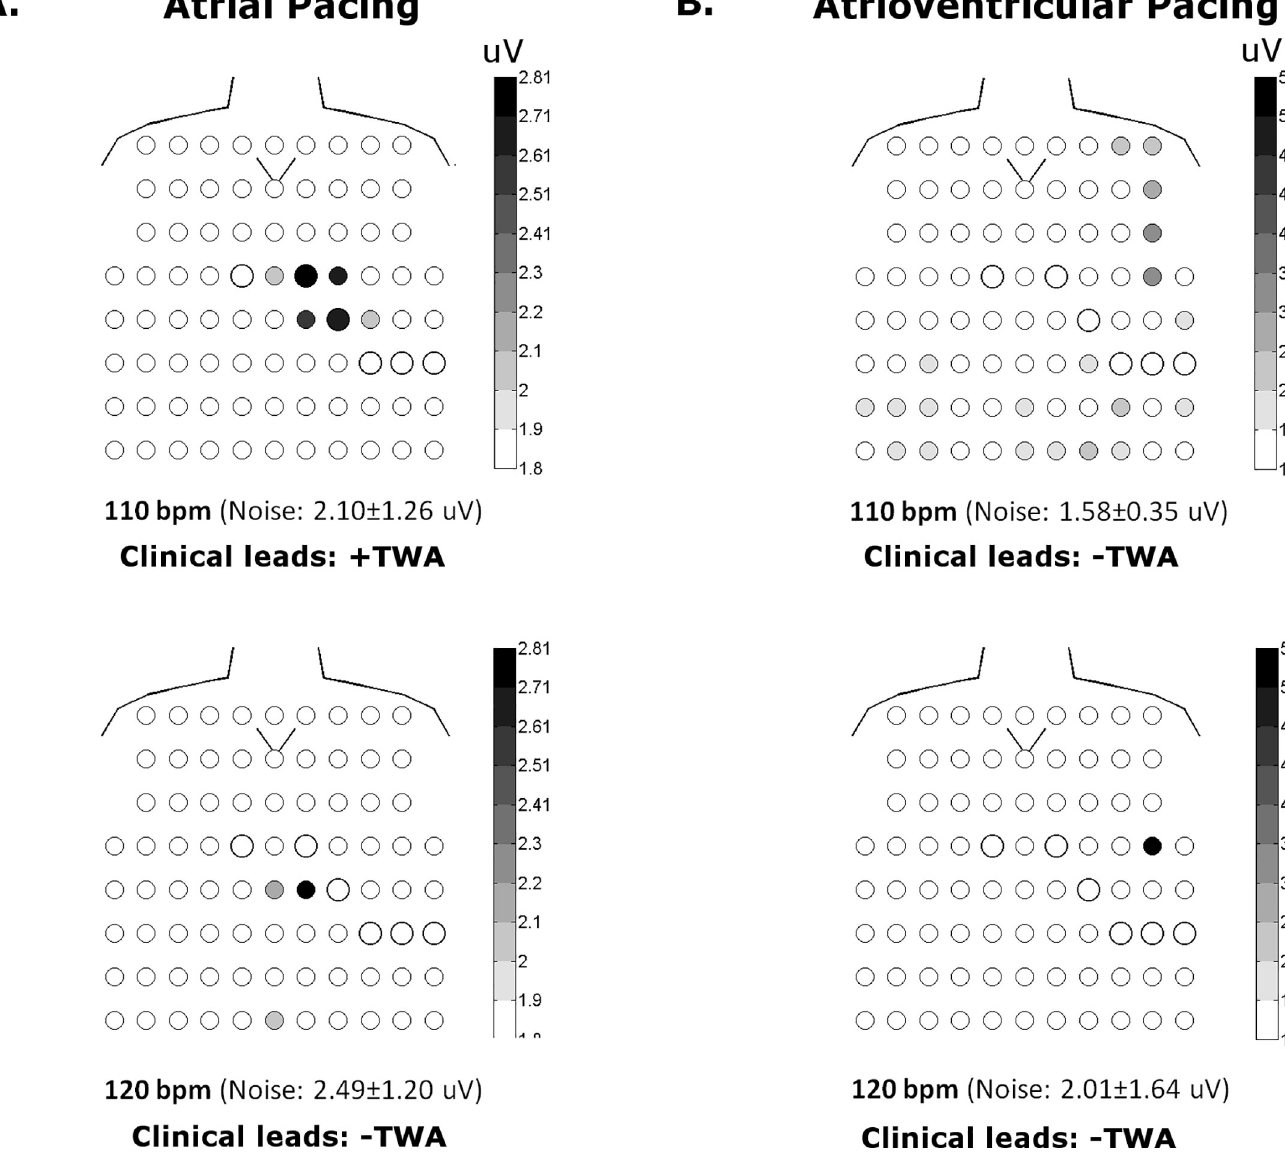
PLOS ONE | https://doi.org/10.1371/journal.pone.0214729 April 10,